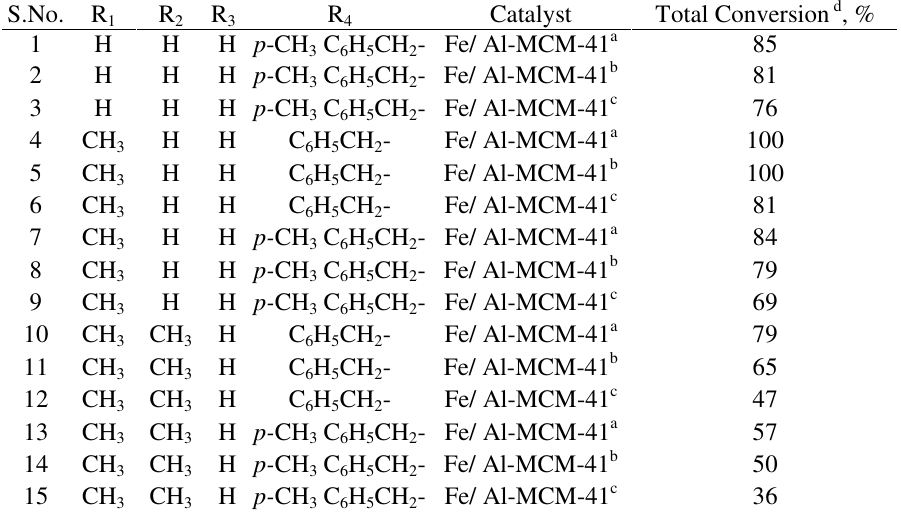
Table 3 . Synthesis of diphenylmethane derivatives over various iron loaded catalysts at reflux condition *